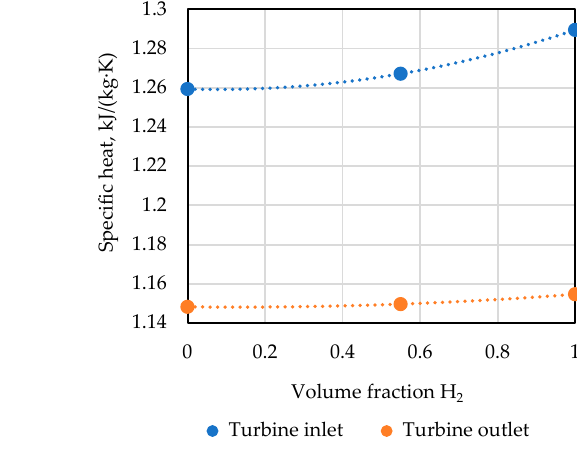
2.5 times greater than at its outlet (Figure 10b).